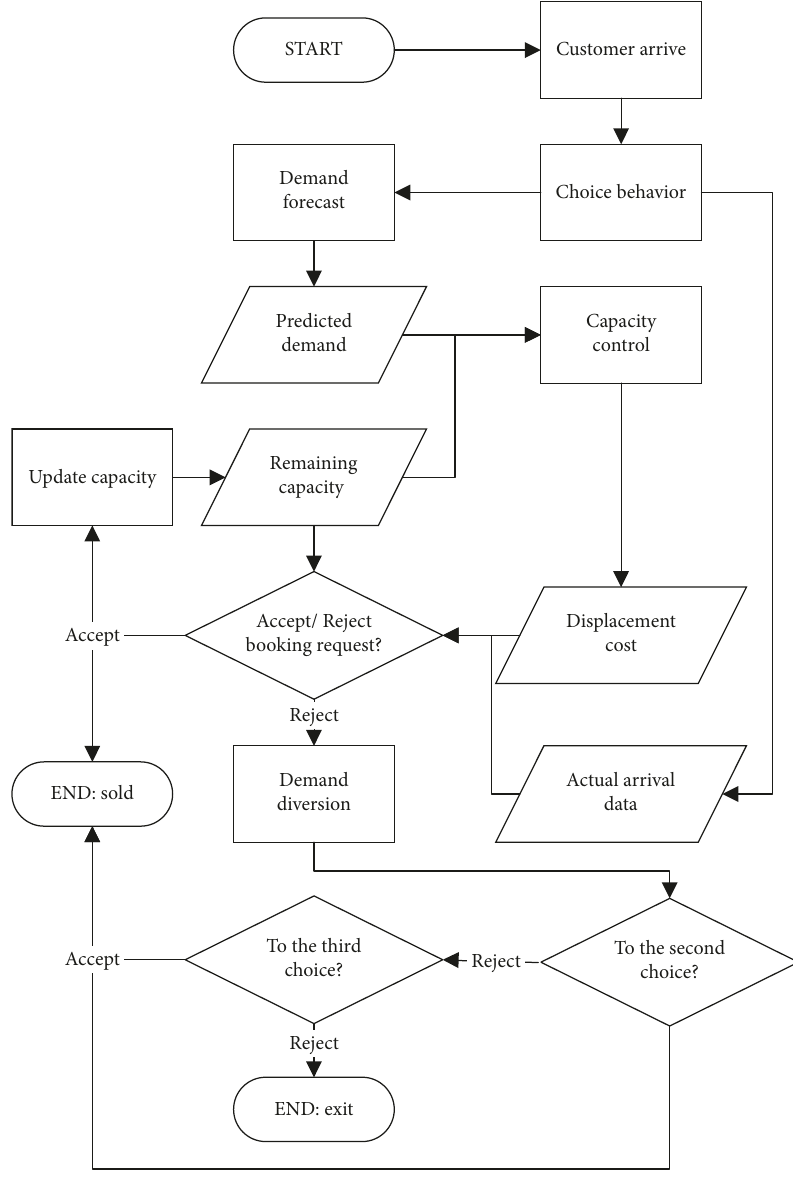
Figure 2: Flowchart of the proposed